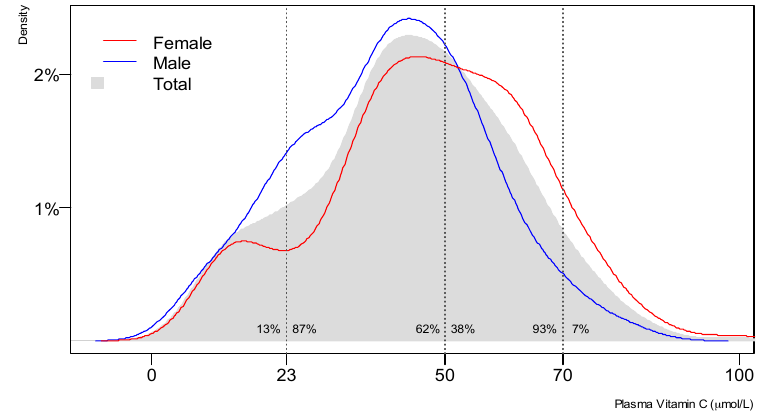
Figure 1. Density plot of plasma vitamin C. Proportion of sample at given vitamin C level; n = 369.